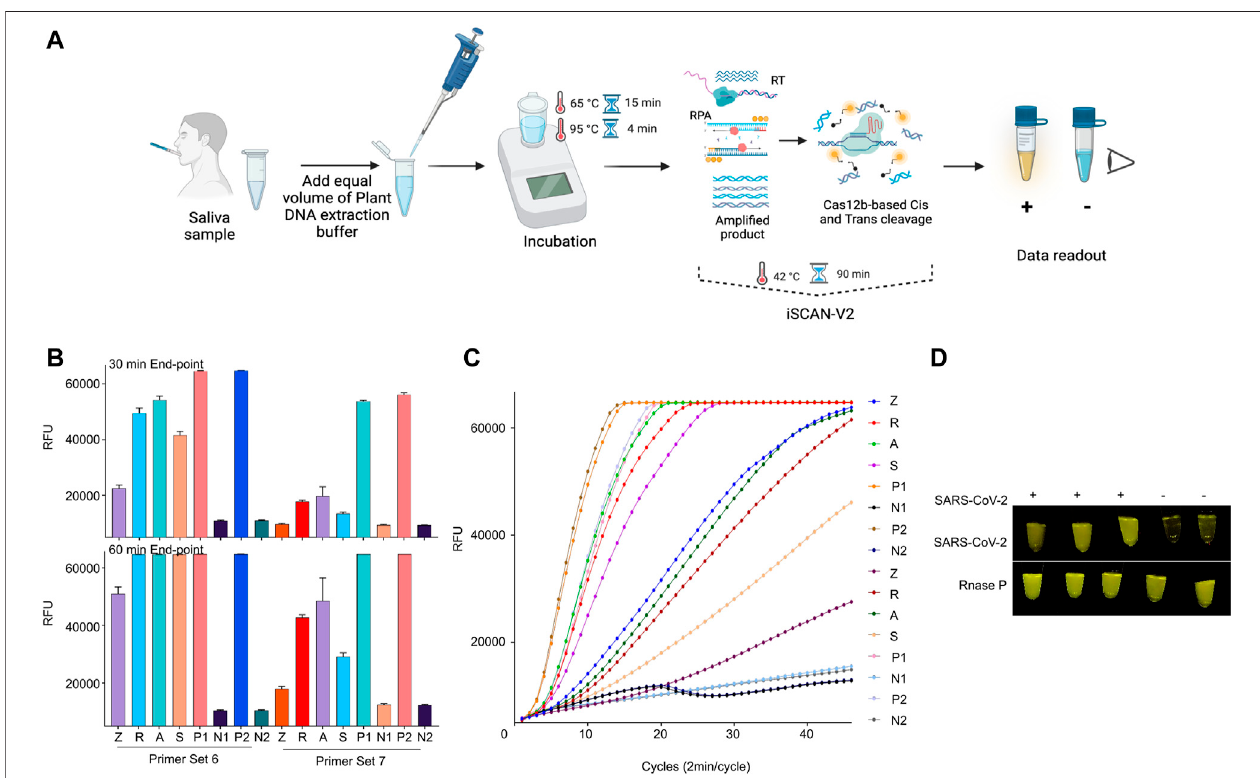
FIGURE8| iSCAN-V2 iscompatiblewithPOCdiagnosticsetup. (A) SchematicofiSCAN-V2-basedPOC detection ofSARS-CoV-2. (B) iSCAN-V2one-potassay for RNaseP detection. Total RNA was isolated from saliva samples using a quick extraction protocol. The extracted RNA samples (Z, R, A, and S) were subjected to the iSCAN-V2 platform for RNaseP detection. P1 and P2 indicate synthetic RNaseP RNA used as an experimental control. N1 and N2 indicate no template controls (NTC; nuclease-free water). (C) Real-time representation of iSCAN-V2 assays shown in (B) . The intensity of the fl uorescent signal was measured every 2 min for a period of 30 min or 1 h. Values shown in the graphs are means of 3 independent readings. (D) iSCAN-V2-based detection of SARS-CoV-2 in SARS-CoV-2-spiked saliva samples. Total RNA extracted from the spiked saliva samples was subjected to the iSCAN-V2 platform for SARS-CoV-2 detection. RNaseP was used as an internal controlforeachsample.(+)indicatesSARS-CoV-2-spikedsalivaand( − )indicatesnon-spikedsaliva.Forend-point fl uorescencevisualization,sampleswereimagedina P51 molecular fl uorescence